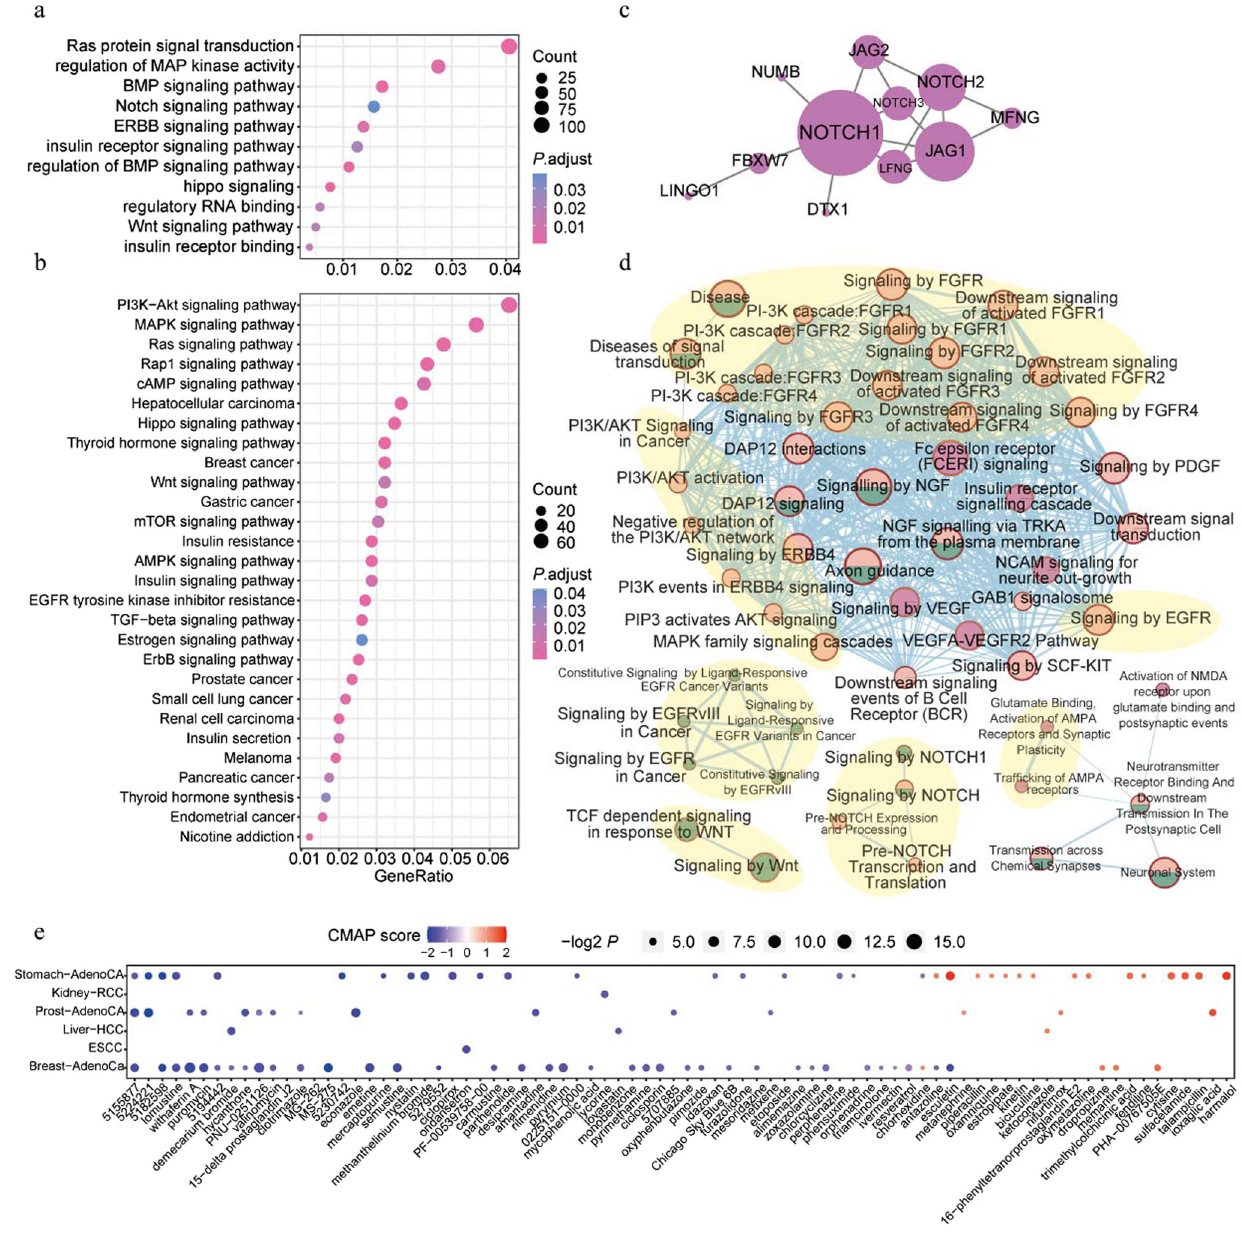
Fig. 6 Systematic functional effect of 3 ′ -UTR piSNV genes. GO ( a ) and KEGG ( b ) functional enrichment of 2930 3 ′ -UTR piSNV genes; the signi fi cant pathological networks ( c ) and pathways ( d , pink: 3 ′ -UTR piSNVs; green: damaging mutations; orchid: 3 ’ -UTR piSNVs and damaging mutations; pink and green: 3 ′ -UTR piSNVs or damaging mutations) of 3 ′ -UTR piSNV genes were performed by Hotnet2 and activePathway work fl ow, respectively. The major signaling pathways (PI3K/AKT/FGFR/MAPK signaling, EGFR-related signaling, AMPA-related signaling, Notch signaling, and Wnt signaling pathways) were pointed out by light yellow circular backgrounds ( d ). e Potential clinical drugs identi fi ed by